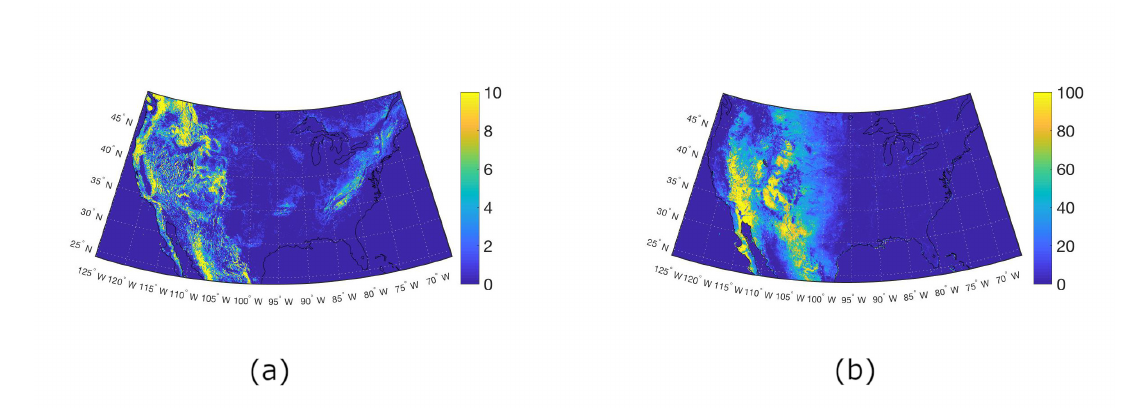
Figure 3. USA map of ( a ) slope of the ground in degrees and ( b ) bare surface fraction